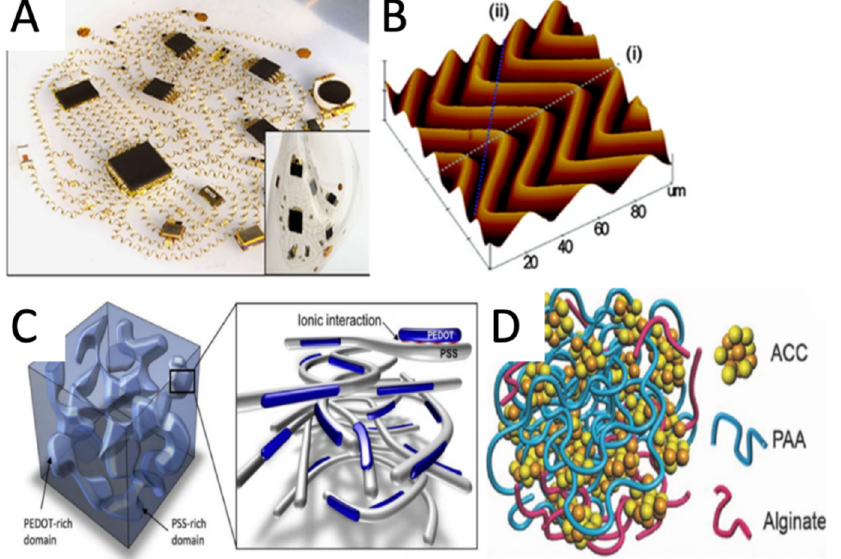
Figure 2. Overview of the conductive materials/methods used for e-skin: ( A ) Network of helical coils as electrical interconnects for soft electronics. Reprinted with permission from [94]; ( B ) AFM image of 2D “wavy” Si nanomembranes on PDMS substrate, reprinted with permission from [66]; ( C ) Schematic diagram of the morphology of a typical PEDOT:PSS film. Reprinted with permission from [67]; ( D ) Schematic structure of the ACC/PAA/alginate mineral hydrogel. Reprinted with permission from [70].